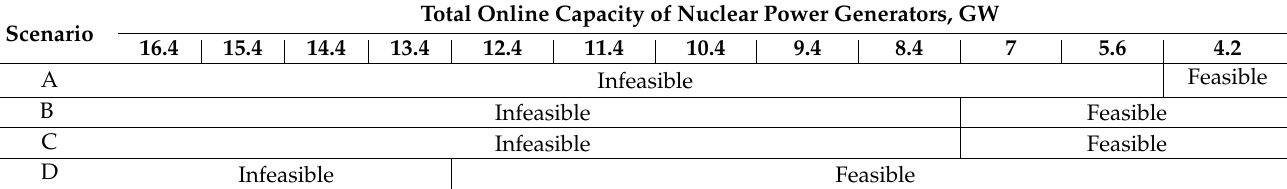
Table 7. Feasibility of each scenario.